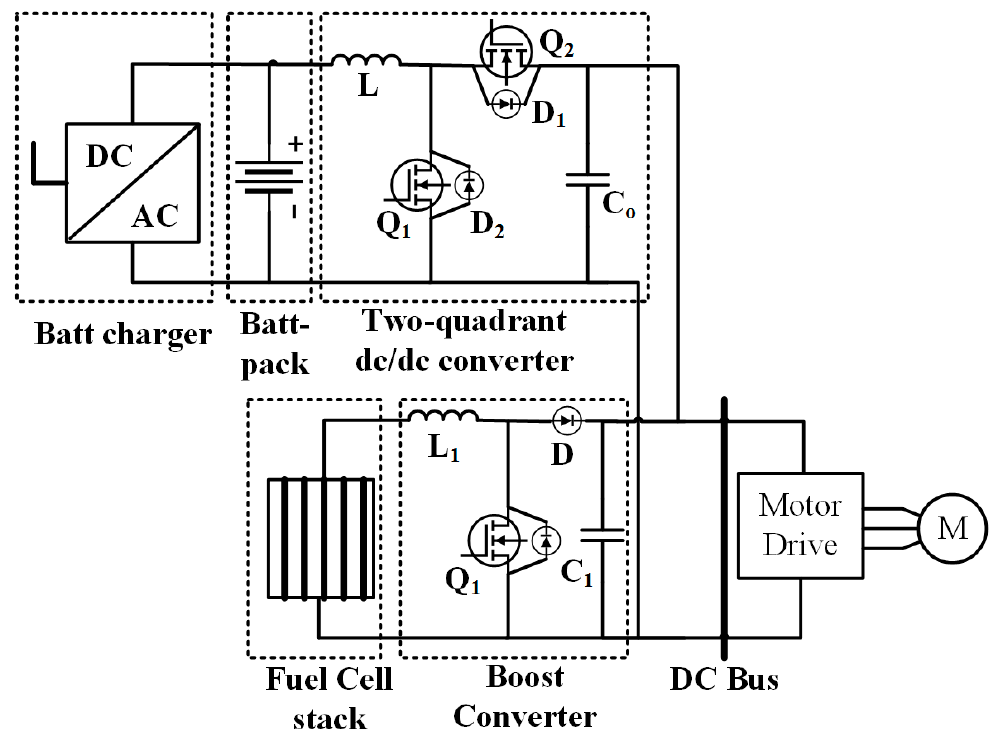
Figure 53. Integrated converter used in PHEV [35].